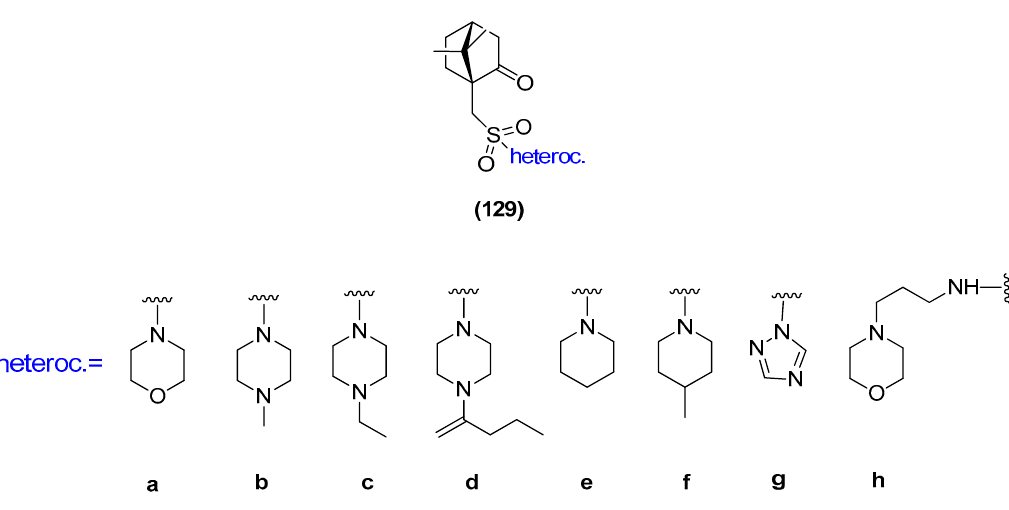
+ )-Camphor-10-sulfonamide Figure 33. (1 S )-(+)-Camphor-10-sulfonamide derivatives. Figure 33. (1 S )-( Figure 33. (1 S )-(+)-Camphor-10-sulfonamide derivatives.